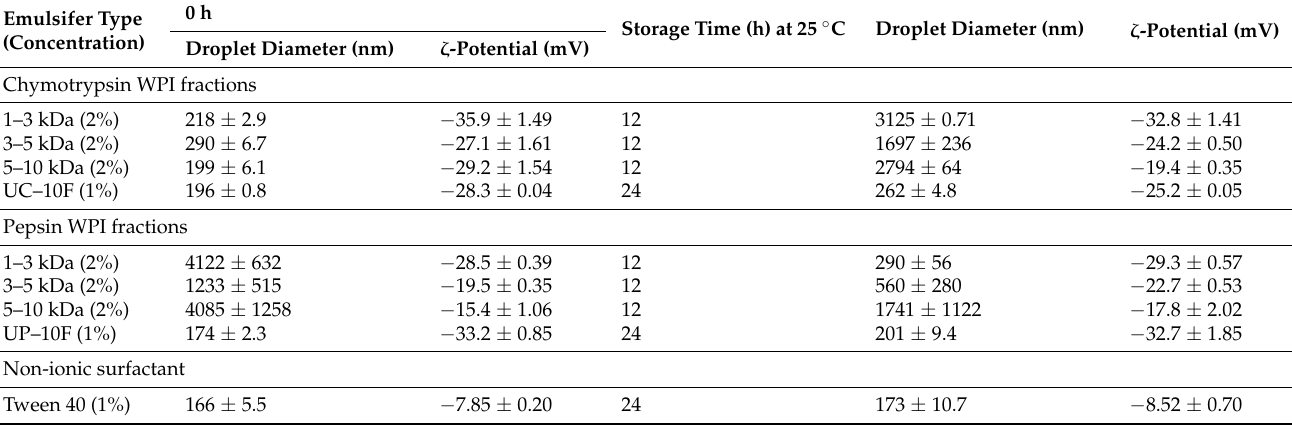
Table 2. Droplet diameter and ζ -potential of (nano)emulsions prepared with the WPI bioactive peptide fractions and Tween 40 at time 0 and 12 or 24